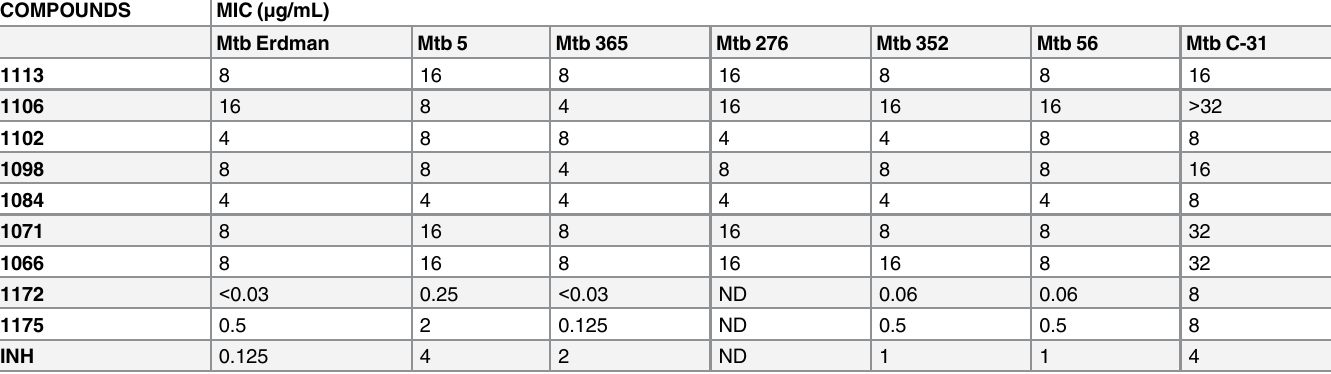
Table 1. Antibacterial activity of propargyl-linked antifolates against multidrug-resistant isolates of M . tuberculosis .